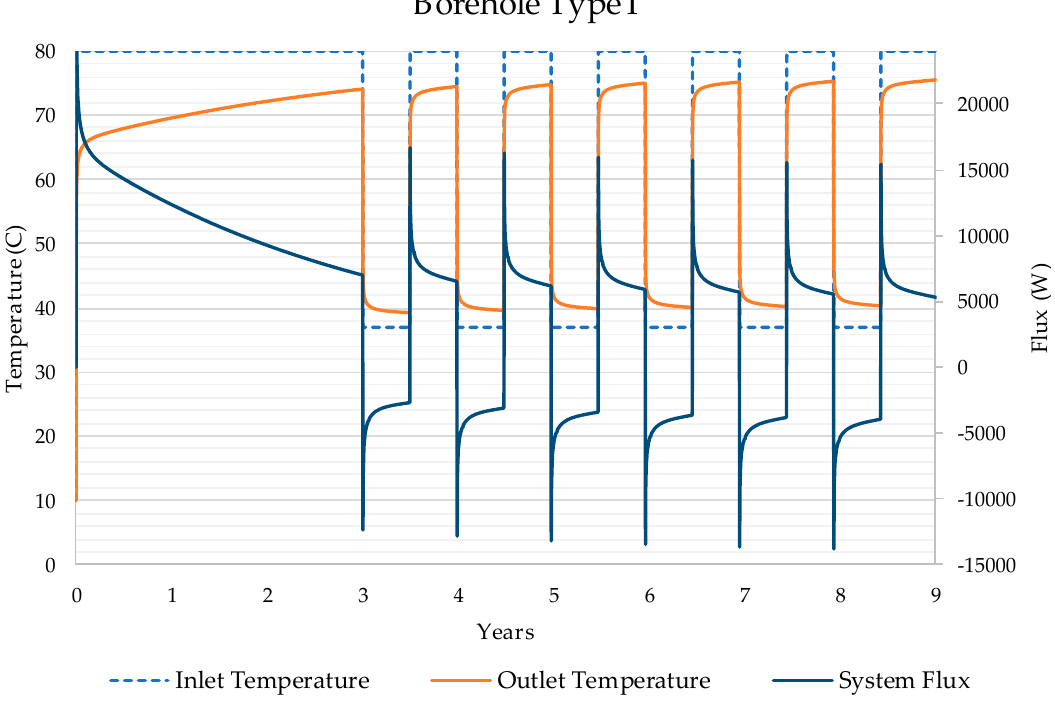
Figure 6. Ground thermal behavior showing three years of heat injection followed by six years of seasonal cyclic thermal storage and recovery process.